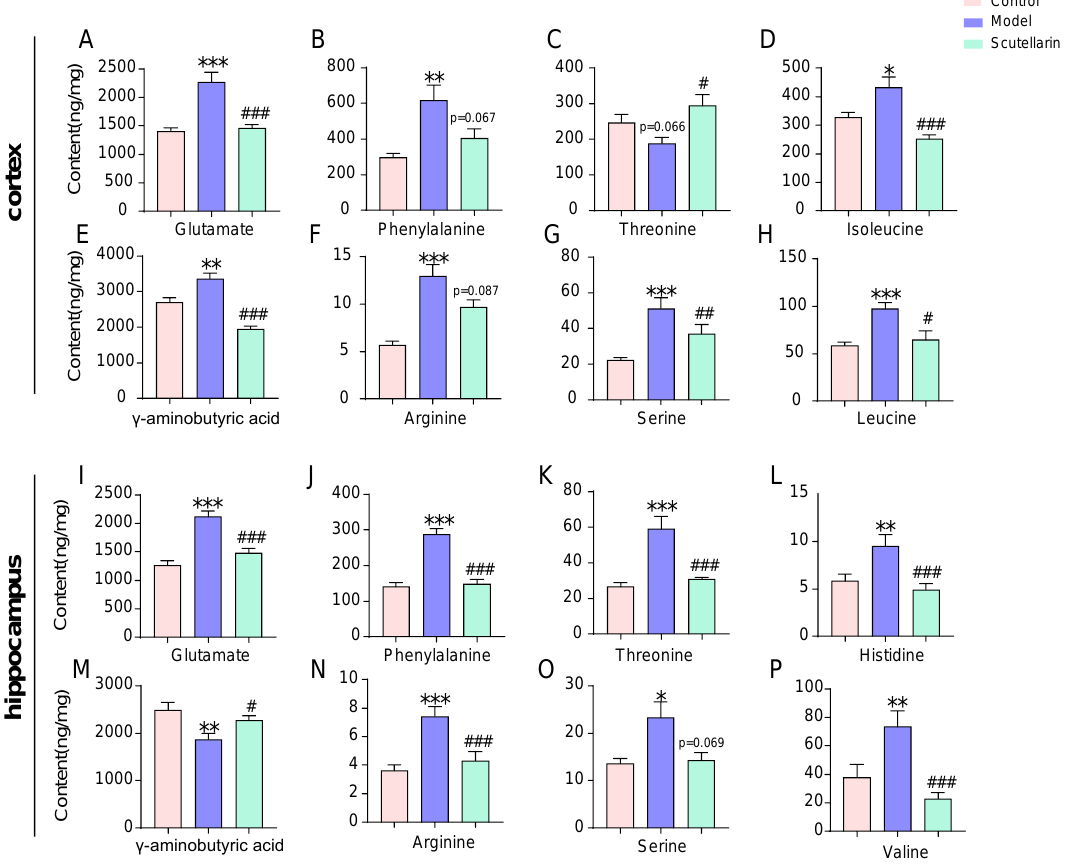
Figure 6 . Targeted quantification of amino acids in cortex ( A – H ) and hippocampus ( I – P ) of MCAO/R model rats at 12 h after reperfusion. Data are presented as mean ± SD , t-test, vs. control group: * p < 0.05, ** p < 0.01, *** p < 0.001; vs. model group: # p < 0.05, ## p < 0.01, ### p < 0.001.